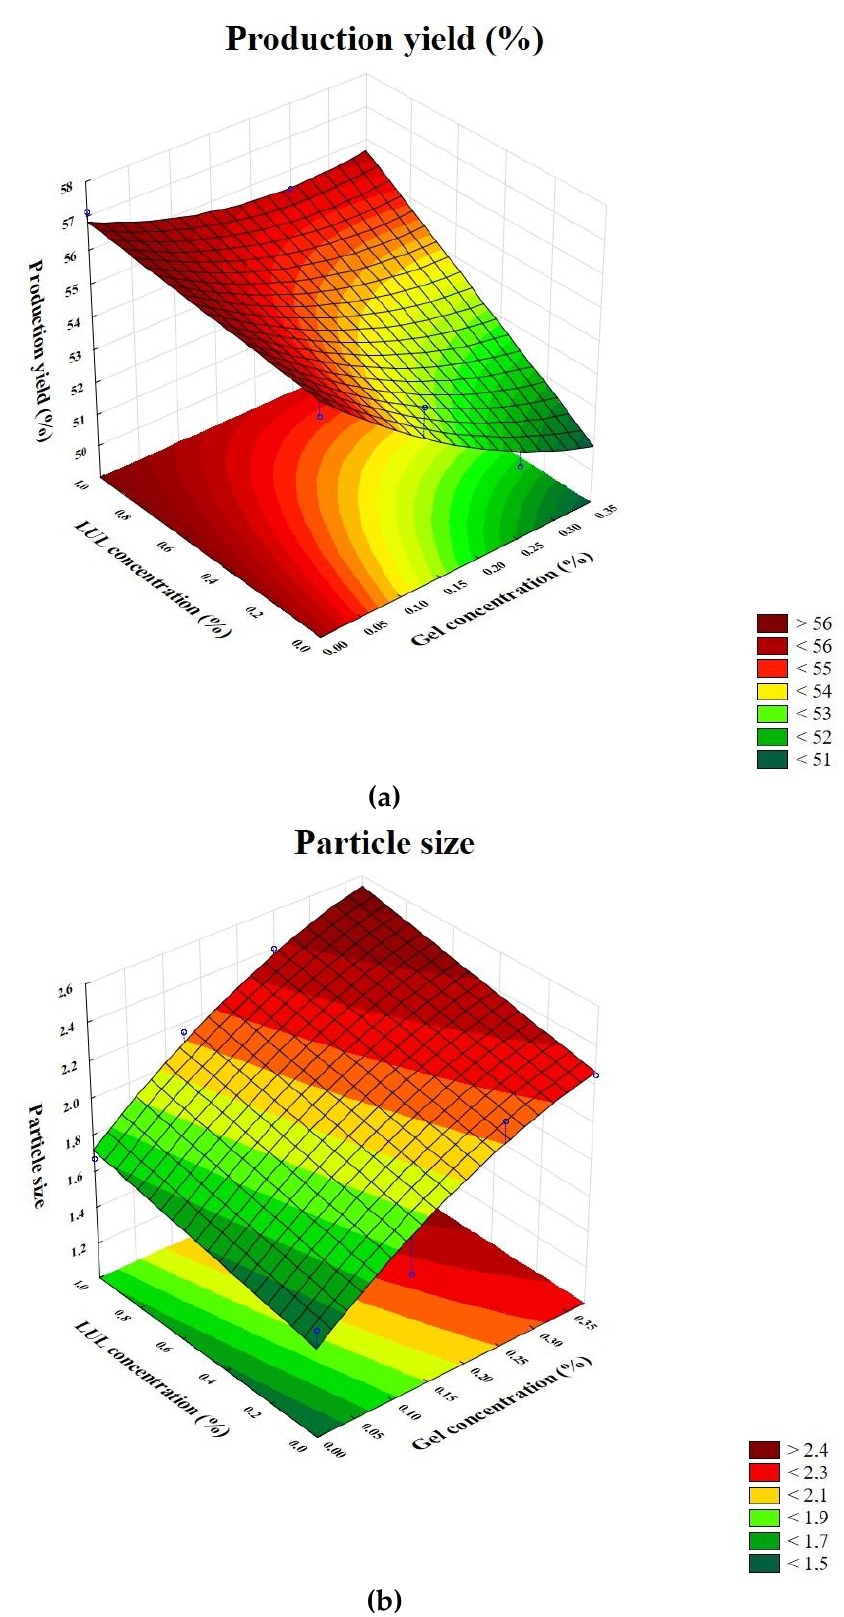
Figure 5. Three-dimensional response surface plots: ( a ) production yield vs. LUL presence and GEL concentrations and ( b ) particle size vs. LUL presence and GEL concentrations.